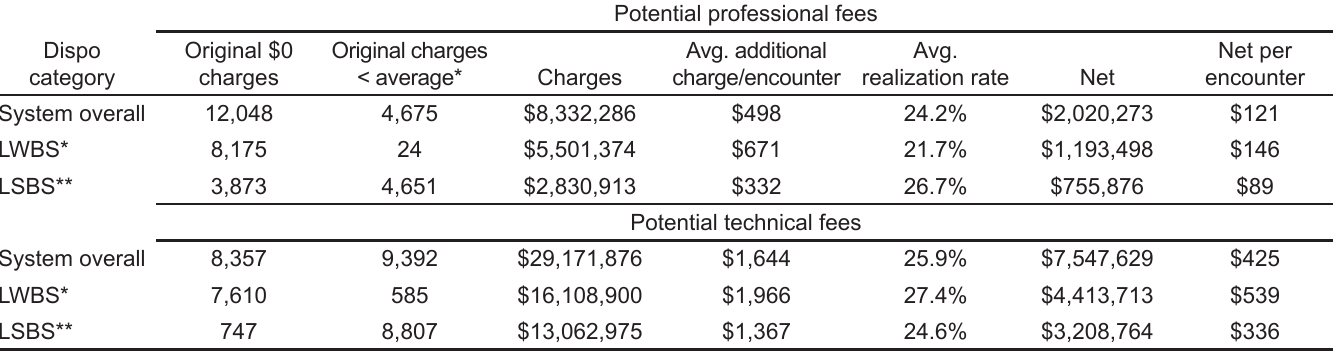
Table 5. Comparison of potential professional and technical fees for left before treatment complete patients.